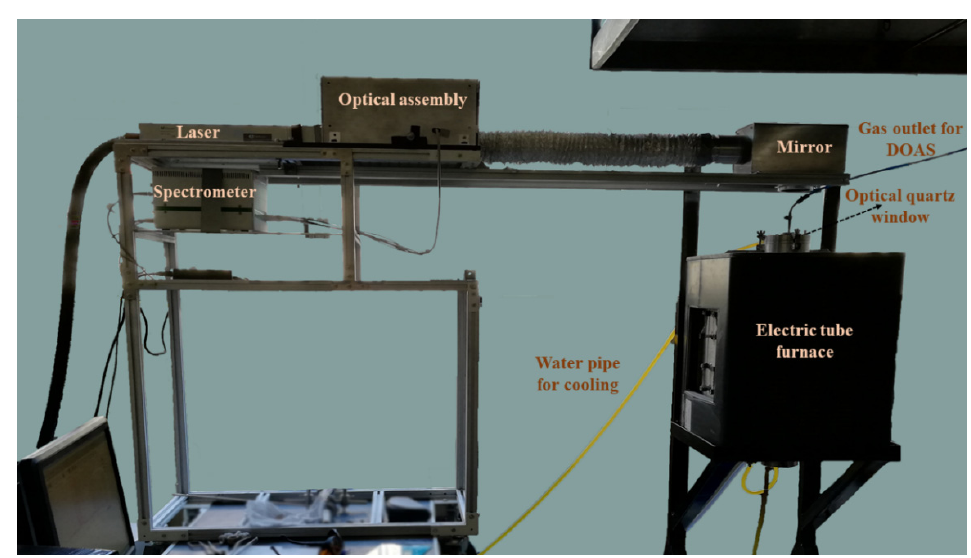
Figure 5. LIBS experimental setup developed for measuring plasma emissions from molten copper blister samples developed by the Departamento de Química Analítica e Inorgánica, Facultad de Ciencias Químicas, Universidad de Concepción.